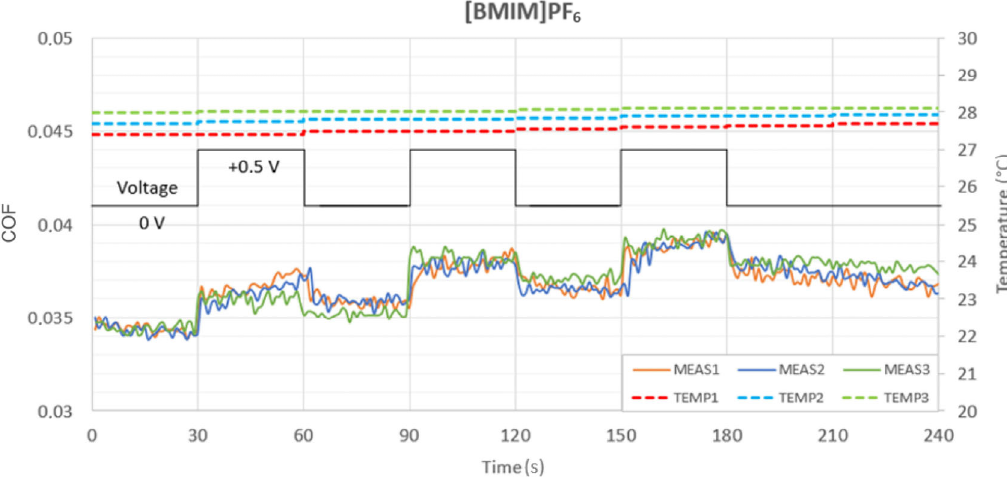
Fig. 9 [BMIM]PF 6 COF and temperature dependence on voltage change.